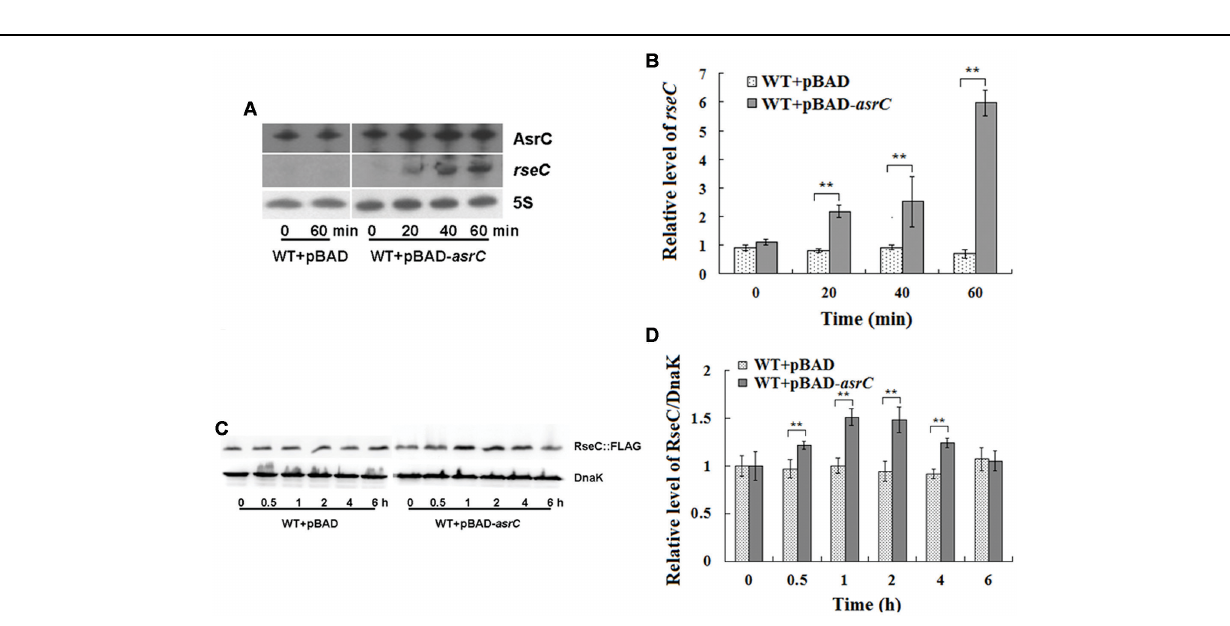
Frontiers in Microbiology |